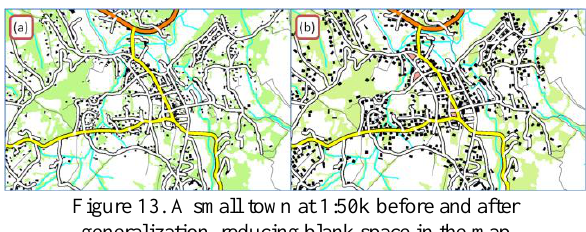
Figure 13. A small town at 1:50k before and after generalization, reducing blank space in the